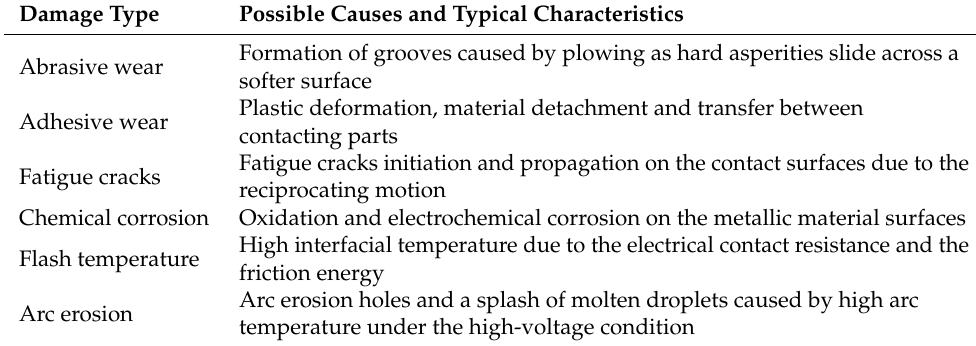
Table 1. Wear and damage mechanisms in electrical